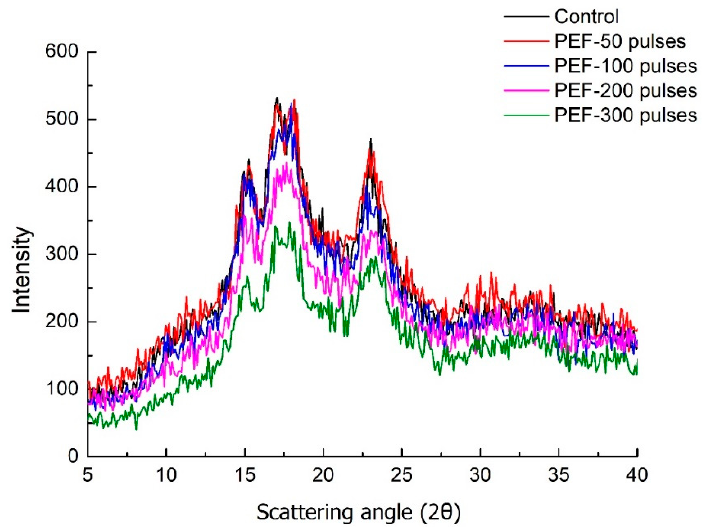
Figure 2. Overlay X-ray diffractograms of control and PEF-treated glutinous rice flour at the field Figure 2. Overlay X ‐ ray diffractograms of control and PEF ‐ treated glutinous rice flour at the field strength of 3 kV/cm for 50, 100, 200 and 300 strength of 3 kV/cm for 50, 100, 200 and 300 pulses.